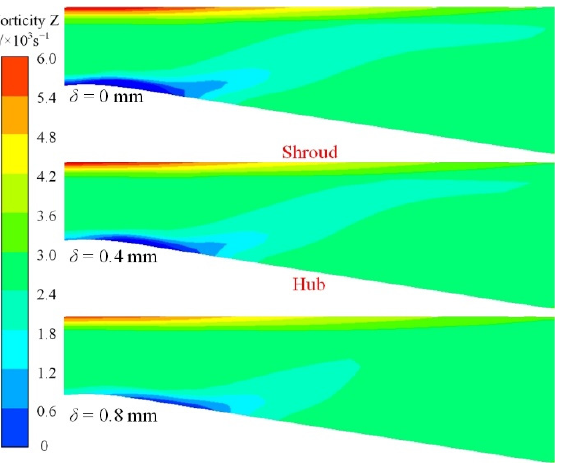
Figure 8. Distributions of the Z component of vorticity on the meridional plane in the guide vane.